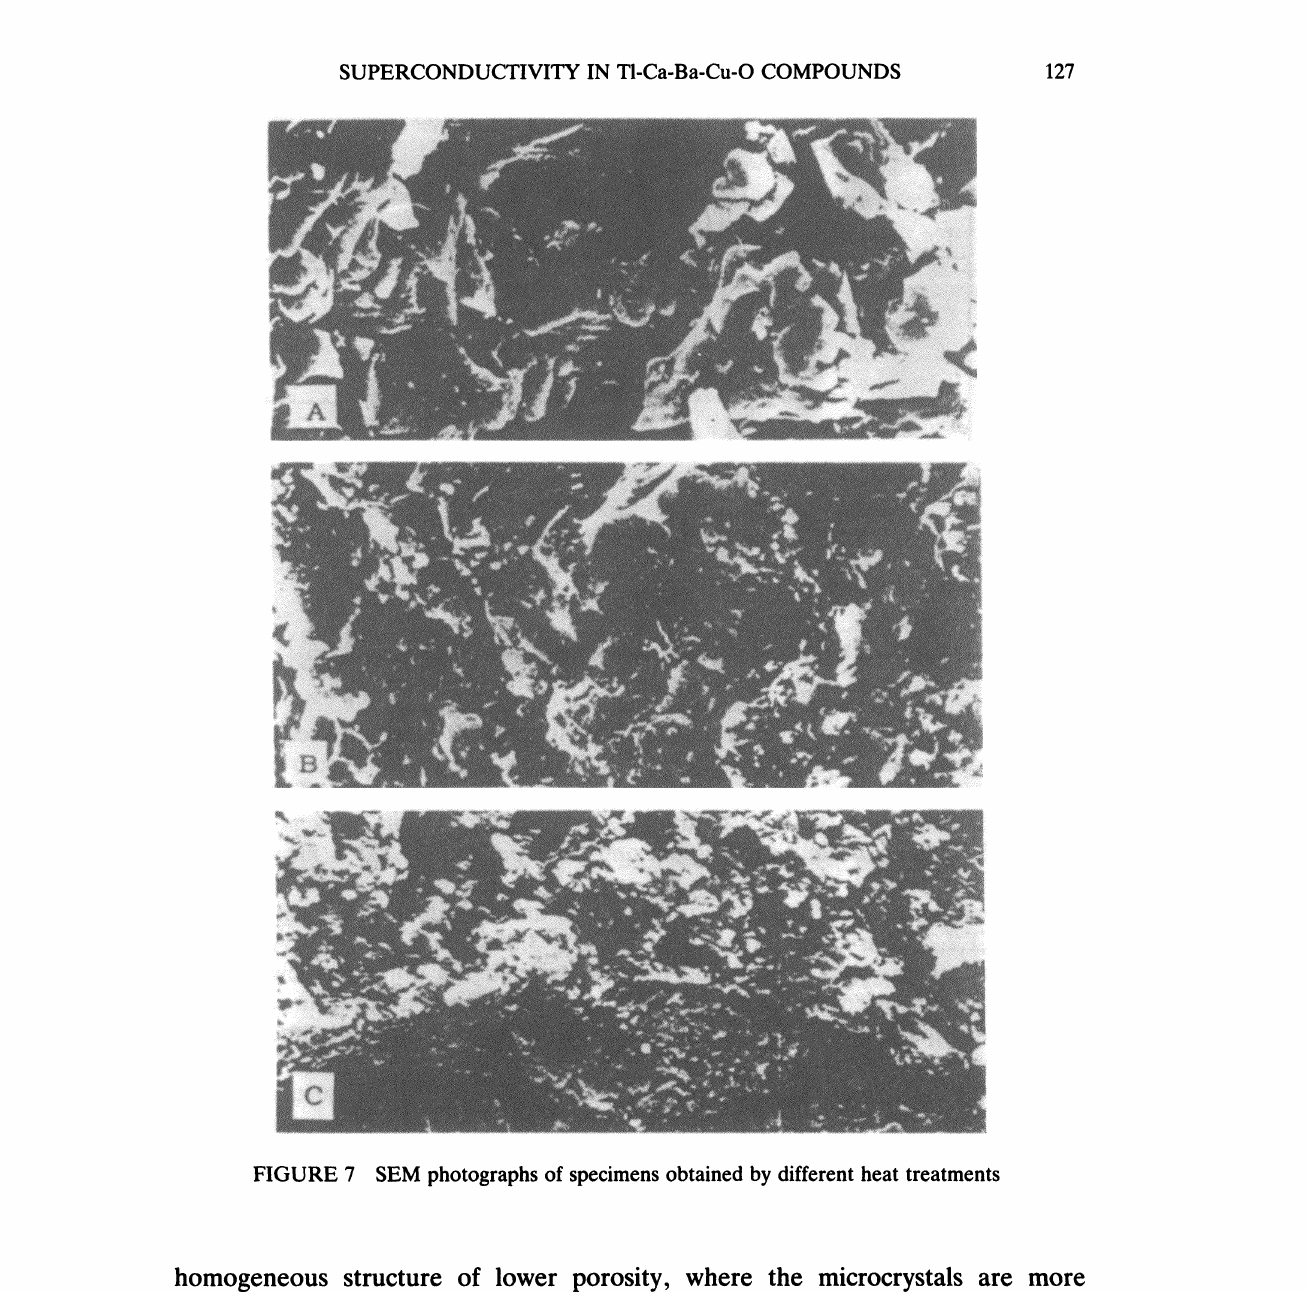
FIGURE 7 SEM photographs of specimens obtained by different heat